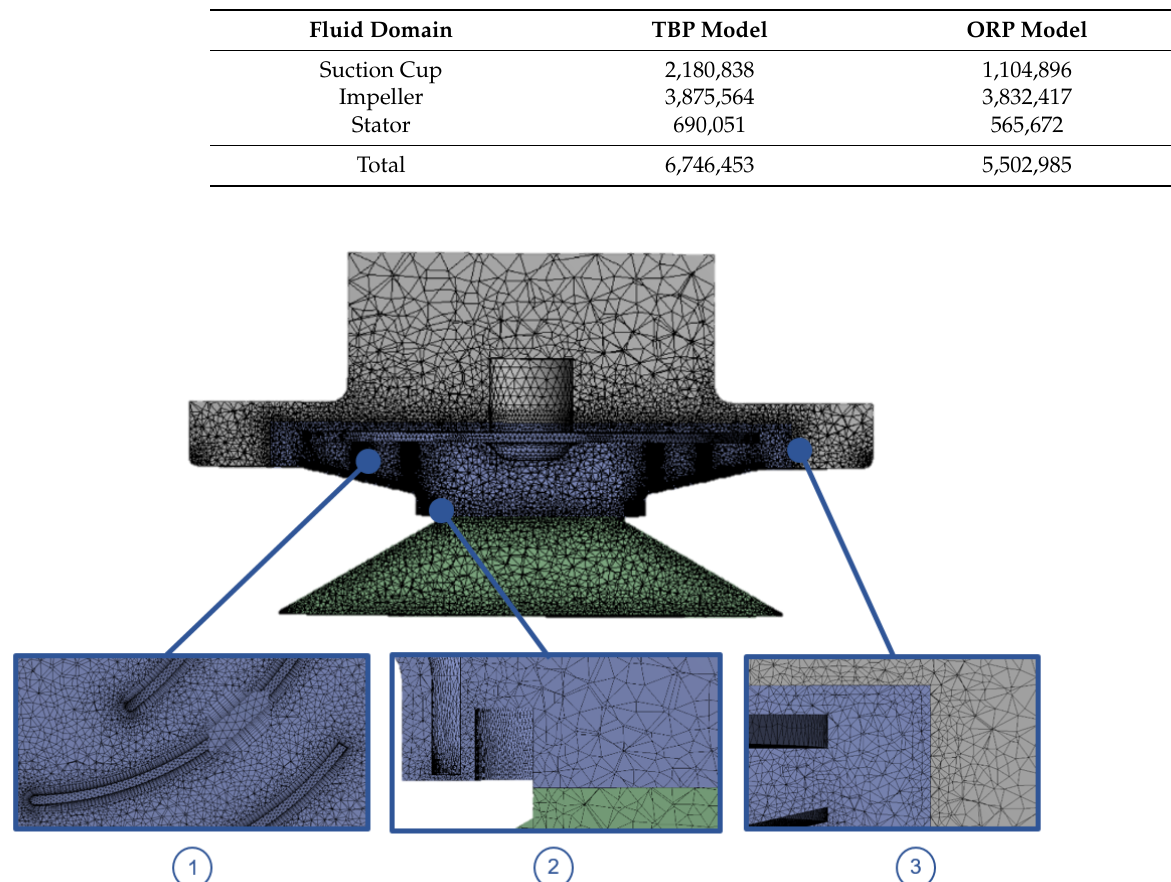
Table 3. Mesh elements in detail for each flow domain.